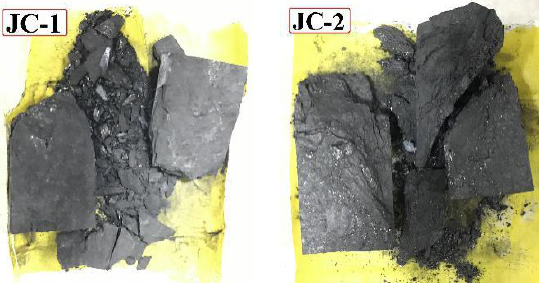
Figure 4. Creep testing curves under different stress levels.